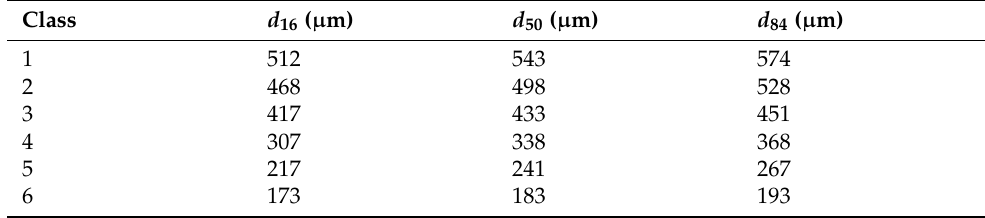
Figure 2. Left panel: Particle diameter distributions for the six selected classes. Right panel: Example of microscope images with the particle diameter measurements. Table 2. Main parameters for the six selected classes of PMMA